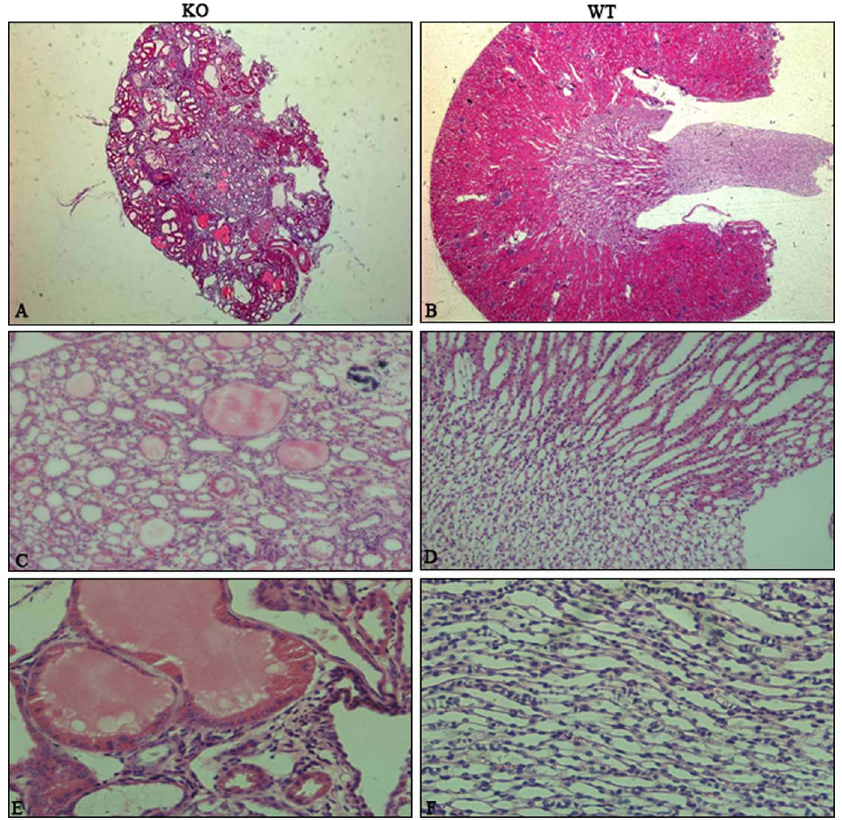
Figure 2. Dominant multiple cysts occurred in the kidneys of the Gpr48 KO mice. The representative morphology of hematoxylin-eosin stains on kidney sections from Gpr48 WT and KO littermates at the adult age. Dominant multiple cysts occurred in the kidneys of the Gpr48 KO mice (A,C,E), whereas the kidneys in the WT mice (B,D,F) were normal. (Magnification, 25 6 for (A,B), 200 6 for (C,D), and 400 6 for (E,F)).